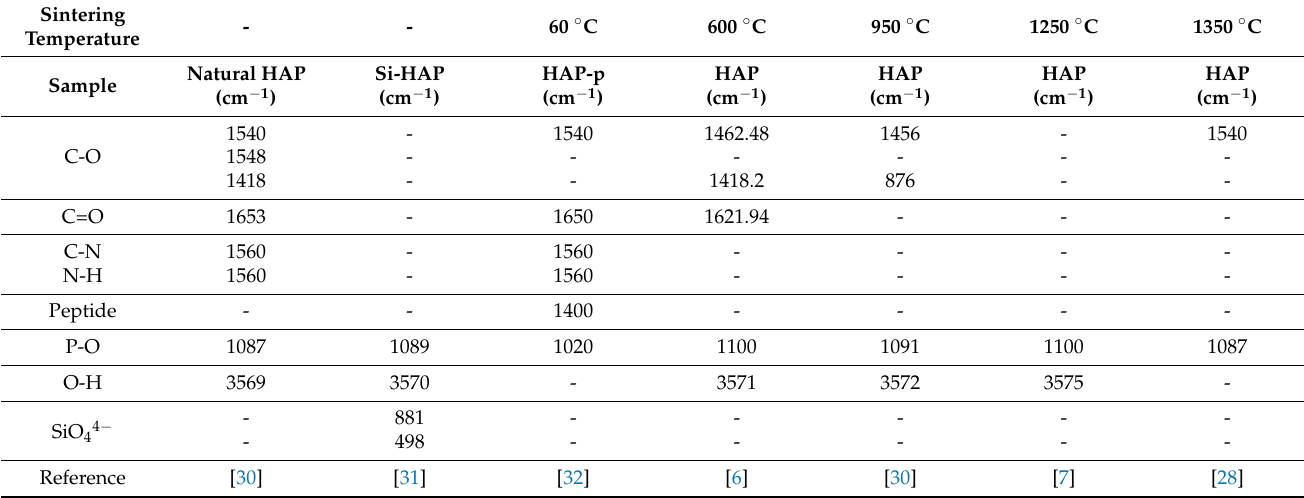
Table 1. Vibration frequencies in FTIR spectrums from different HAP samples sintered and treated at different temperatures. Sintering